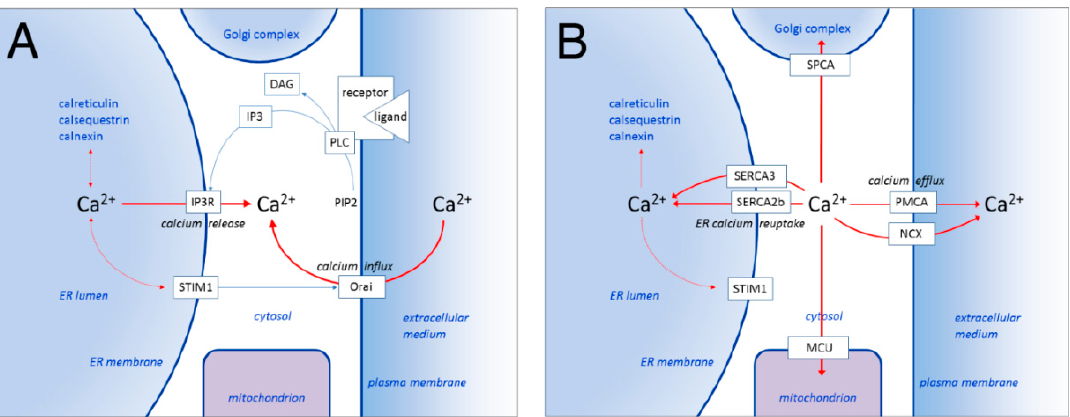
Figure 1. A simplified scheme of cellular calcium compartments, transporters and calcium ion fluxes. ( A ) Calcium mobilization during a cell activation event. Upon activation of plasma membrane receptors, phospholipase C (PLC)-induced hydrolysis of the membrane lipid phosphatidylinositol 4,5-bisphosphate (PIP2) leads to the formation of the second messengers diacylglycerol (DAG) and inositol 1,4,5-trisphosphate (IP3). Binding of IP3 on IP3-receptor calcium channels located in the ER membrane leads to channel opening and passive di ff usion of calcium ions from the ER lumen into the cytosol (calcium release). Dissociation of calcium ions from the intraluminal part of STIM proteins located in the ER membrane leads to their interaction with Orai-type calcium channels located in the plasma membrane and Orai channel opening. Calcium influx through Orai channels (capacitative calcium influx) combined with calcium release from the ER leads to increased cytosolic calcium levels and the activation of calcium-dependent downstream signaling. ( B ) Elimination of cytosolic